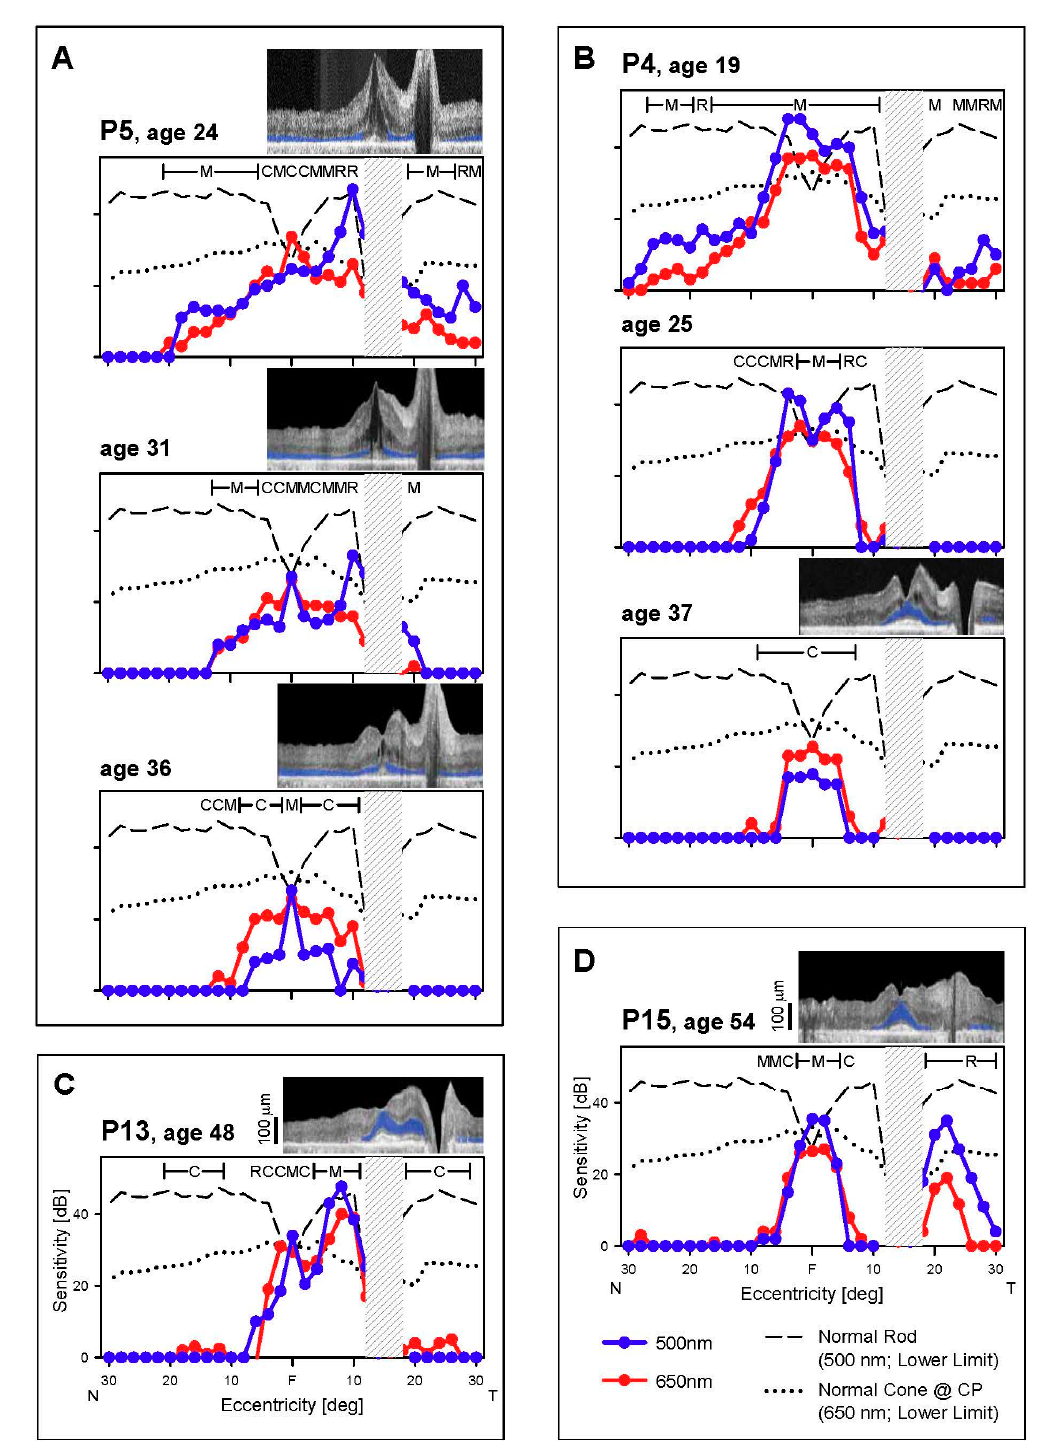
Figure 3. Rod and cone function across the horizontal meridian. ( A – D ) Dark-adapted, two-color profiles measured across the central 60° in four EYS patients. All patients present with reduced rod and cone function. P5 ( A ) and P4 ( B ), the two patients with serial data, show progression of dysfunction to central islands of mainly cone function at the later visits. Hatched bar, location of physiological blindspot. Normal lower limits depicted as in Figure 2. Insets, OCTs colocalized with perimetry. F, fovea; N, nasal and T, temporal visual field.